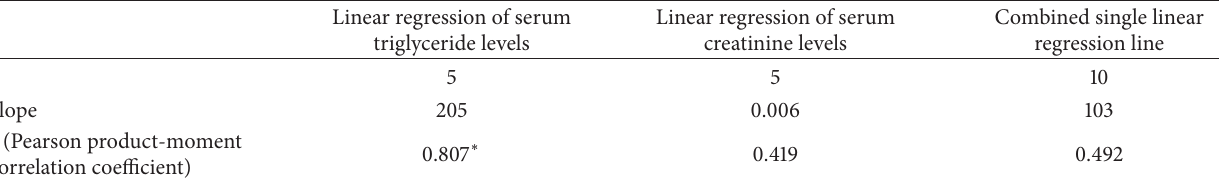
Table 2: Results: correlation of increases in serum triglyceride and creatinine levels over propofol infusion durations.